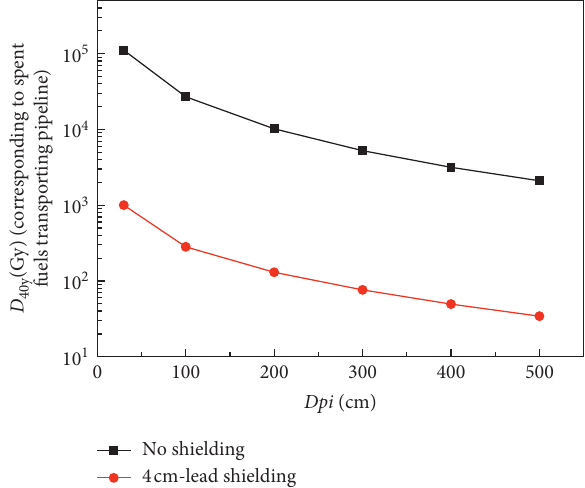
Figure 5: D 40y at different Dpi positions for a 5 m pipeline.